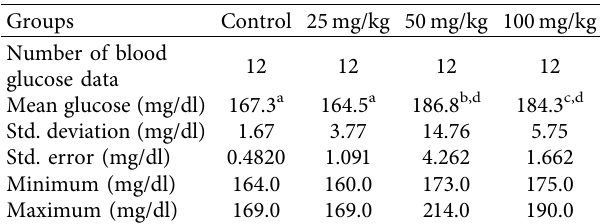
a–d Different letters indicate statistical significant differences ( P < 0 .